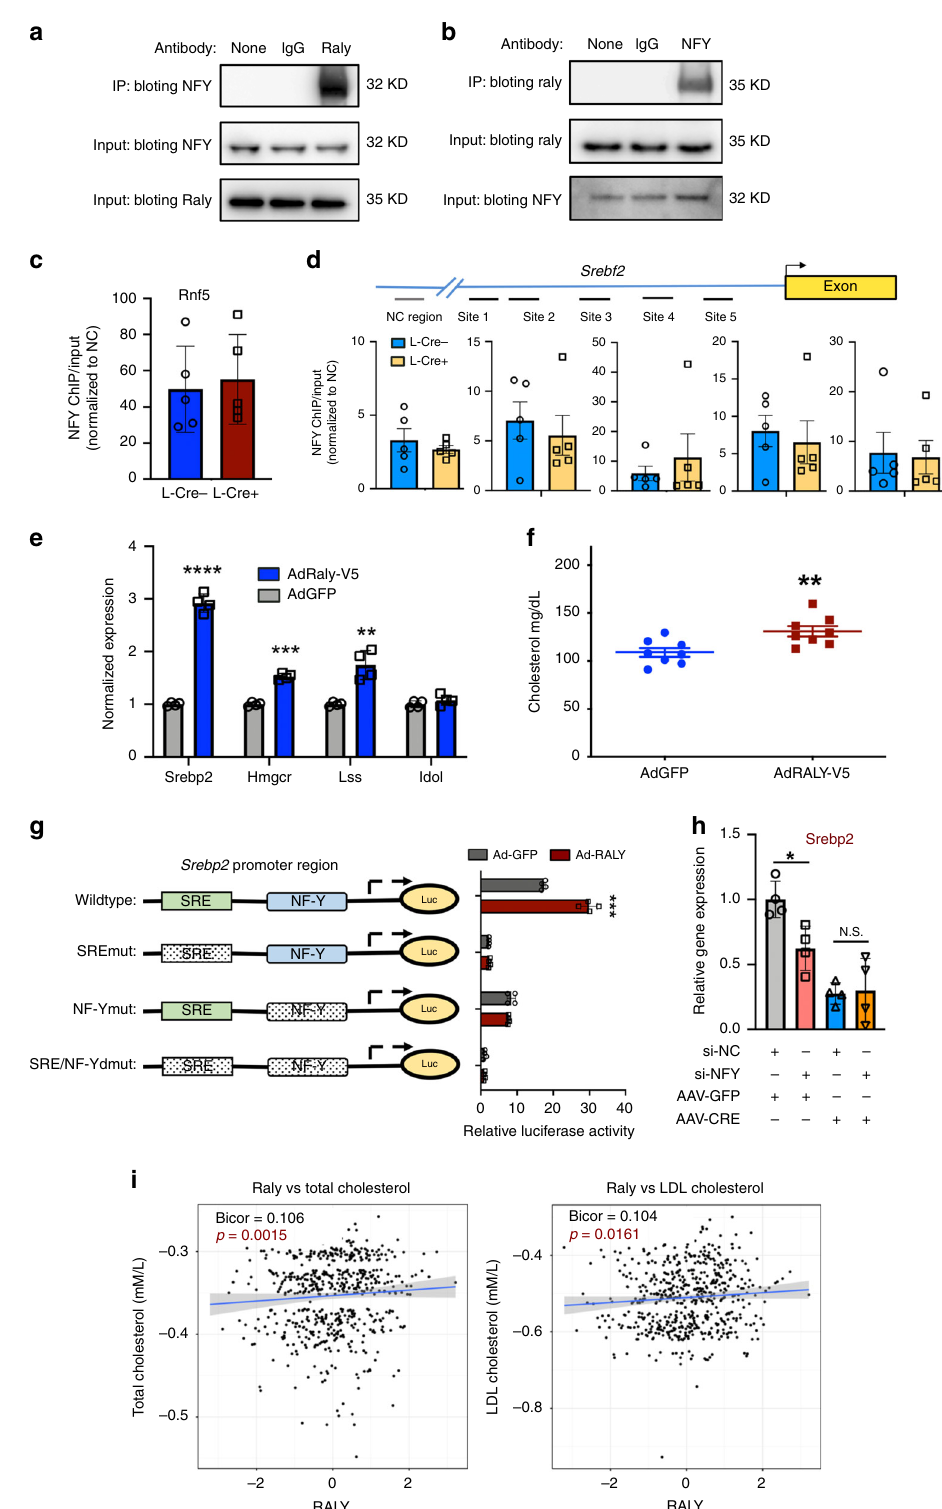
Fig. 4 The coactivator NFY is required for the transcriptional effects of RALY on cholesterogenesis. a , b Western blot from Co-IP studies performed in hepa1-6 cells. c NFY ChIP-qPCR of the positive control NFY gene done from Raly f/f L-Cre + or L-Cre − livers ( n = 5 per group). d ChIP-qPCR on Srebf2 promoter using various primers around NFY sites from ChIP in c . Data were normalized to negative control region; ( n = 5 per group). Data are mean± SEM. e Gene expression results from hepa1-6 cells treated with adenovirus GFP or RALY ( n = 4 per group). f Serum cholesterol levels from chow-fed mice treated with adenovirus GFP or RALY harvested after 6 days of injection. Data mean± SEM; ( n = 8 per group). g Luciferase promoter assays of Srebp2 promoter region performed in hepa1-6 cells and with GFP or RALY overexpression. h Srebp2 gene expression after NFY knockdown in control or RALY- de fi cient primary hepatocytes ( n = 4 per group); values are mean±SD. i Gene expression results from METISM study showing correlation of metabolic traits with RALY. Values are inverse normal transformed. * P < 0.05; ** P < 0.01, *** P < 0.001, and **** P <